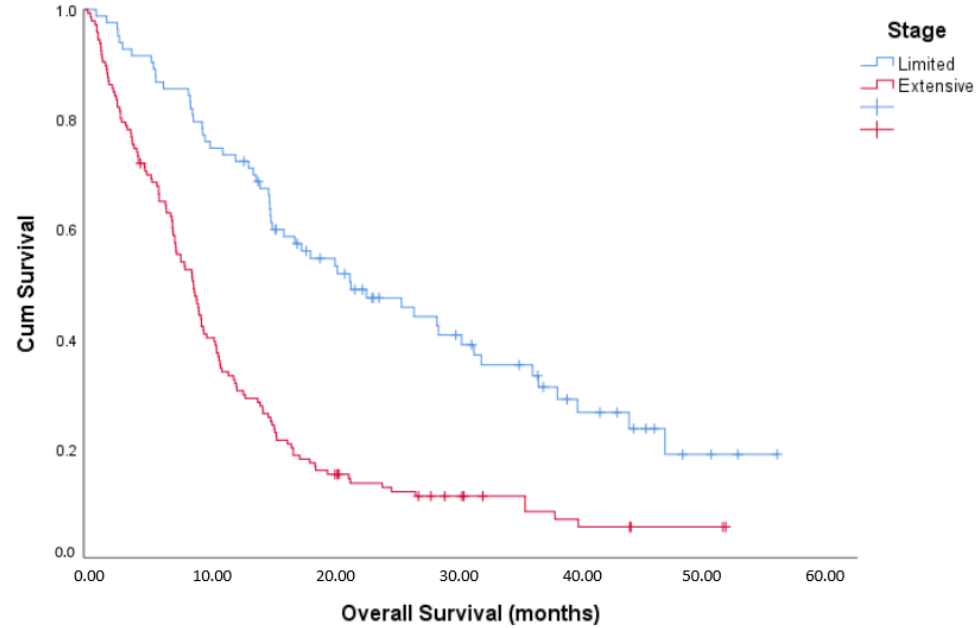
Figure 1. Kaplan–Meier overall survival curves. Table 4. Patterns of relapse and outcomes of